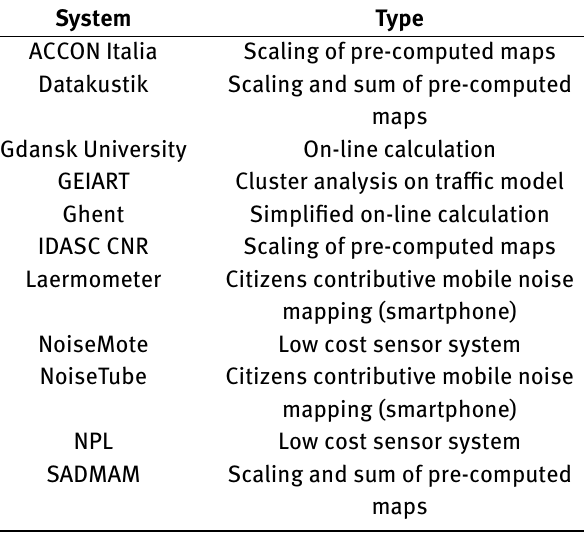
Table 1: Analyzed systems. System